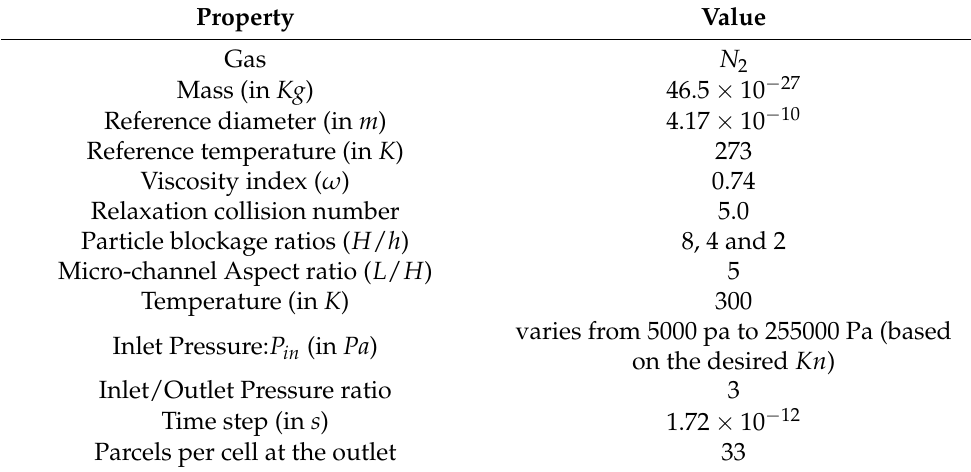
Table 1. DSMC simulation conditions for a 2D planar micro-channel Poiseuille